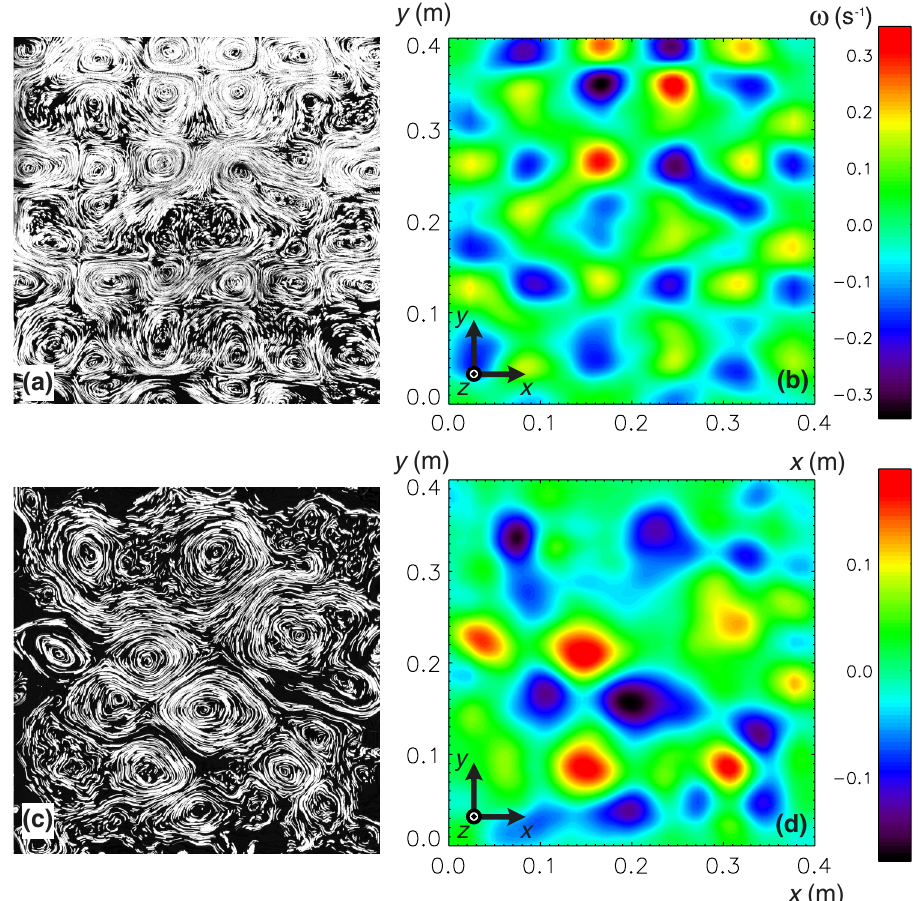
FIG. 6. Flow driven by Faraday waves excited at the water surface at f 0 ¼ 10 Hz and a ¼ 0 . 04 g in a 40 × 40 cm 2 square container. Left: Fluid particle trajectories 1 min (a), 10 min (c) after the shaker has been turned on. In those images, particle streaks correspond to a 4 s time interval. Right: Corresponding vorticity fields measured by PIV techniques (see details in the Appendix) and averaged over a 4 s time interval ( ¼ 20 T ). Movies were recorded at 5 frames per second with a spatial resolution of 200 μ f